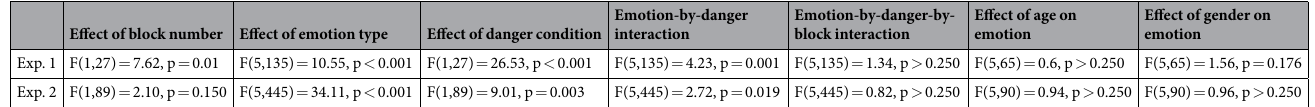
Table 3. Full statistics for Experiments 1 and 2 for analyses of the effect of disaster condition on